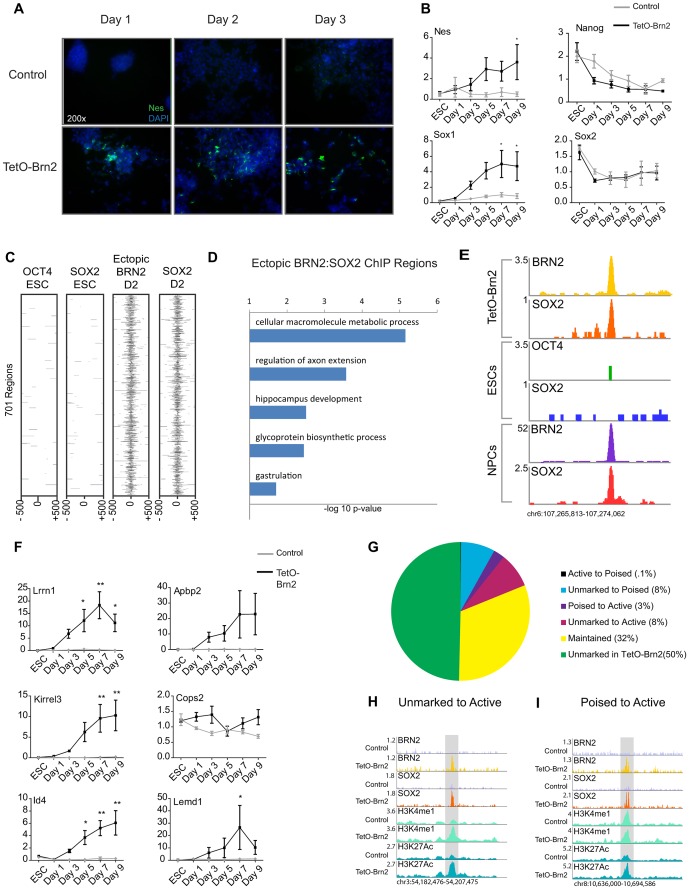
Brn2 biases ES cells towards neural differentiation.(A) Staining with DAPI (blue) and immunocytochemistry of NESTIN (green) in ESCs induced to differentiate in adherent cultures with or without ectopic Brn2. (B) qRT-PCR of the indicated genes in ESCs with (black lines) and without (gray lines) ectopic Brn2 expression through differentiation. y-axis represents relative expression normalized to Gapdh in 3 biological replicates, measured in triplicate. ESC time point is ESCs without doxycycline, and d1–d9 time points represent time in differentiation medium. * denotes p-value<0.05, ** denotes p-value<0.01 ANOVA with Bonferroni correction (C) Heatmap of OCT4 and SOX2 enrichment in ESCs and ectopic BRN2 and SOX2 in TetO-Brn2 cells of 701 genomic regions occupied by only ectopic BRN2 and SOX2. (D) GREAT GO biological processes enriched in 701 regions in (C). x-axis reflects negative log base 10 of raw binomial p-value for enrichment versus a whole genome background. (E) Gene plots depicting peaks of enrichment in indicated datasets at a locus distal to Lrrn1. y-axis corresponds to reads per million. Genomic positions reflect NCBI Mouse Genome Build 36 (mm8). (F) qRT-PCR of genes associated with SOX2-BRN2 binding in TetO-Brn2 cells and NPCs, in ESCs with (black lines) and without (gray lines) ectopic Brn2 expression through differentiation. y-axis represents relative expression normalized to Gapdh in 3 biological replicates, measured in triplicate. ESC time point is ESCs without doxycycline, and d1–d9 time points represent time in differentiation medium. * denotes p-value<0.05, ** denotes p-value<0.01 ANOVA with Bonferroni correction. (G) Pie chart reflecting overlap between SOX2-BRN2 regions and enhancer chromatin marks in TetO-Brn2 cells. Percentages in legend reflect fraction of 1,533 SOX2-BRN2 regions in each category. (H) Example region that was occupied by ectopic BRN2 in TetO-Brn2 cells, leading to recruitment of endogenous SOX2 and the deposition of H3K4me1 and H3K27Ac. y-axis corresponds to reads per million. Genomic positions reflect NCBI Mouse Genome Build 36 (mm8). Gray box indicates region of SOX2-BRN2 co-occupancy in TetO-Brn2 cells which was not occupied by SOX2 in control cells. (I) Example poised enhancer occupied by ectopic BRN2 in induced cells, leading to recruitment of endogenous SOX2, and deposition of H3K27Ac. y-axis corresponds to reads per million. Genomic positions reflect NCBI Mouse Genome Build 36 (mm8). Gray box indicates region of SOX2-BRN2 co-occupancy in TetO-Brn2 cells which was not occupied by SOX2 in control cells.